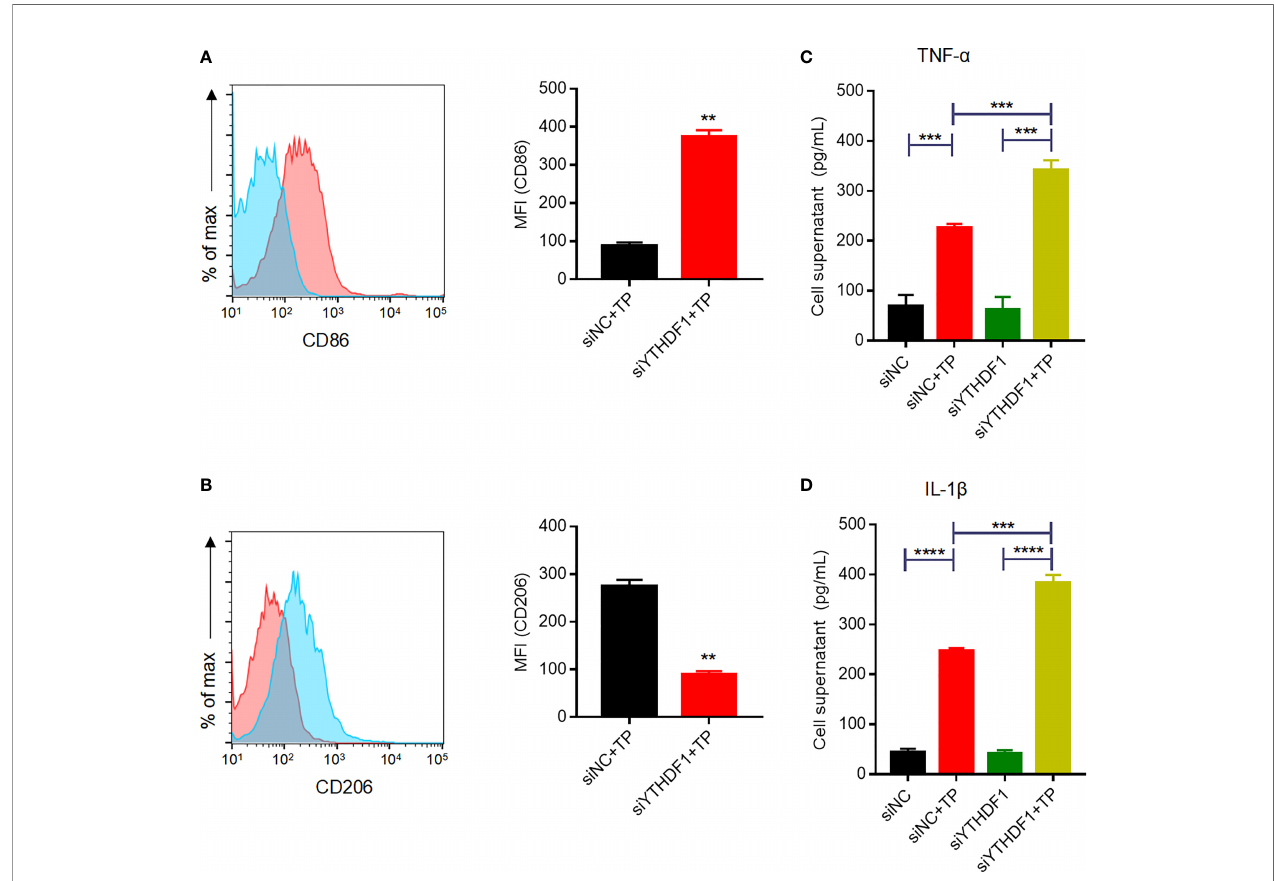
FIGURE 2 | YTHDF1 regulates M2 macrophage polarization and suppresses the secretion of in fl ammatory cytokines in THP-1 cells infected with TP. (A, B) Flow cytometry pro fi le of the expression of M1 and M2 markers (CD86 and CD206) in THP-1 cells infected with TP. (C-D) The concentrations of in fl ammatory cytokines (TNF- a and IL-1 b ) in the supernatants of THP-1 cells treated with TP. Data are shown as the mean ± S.D. **P < 0.01, ***P < 0.001,****P <